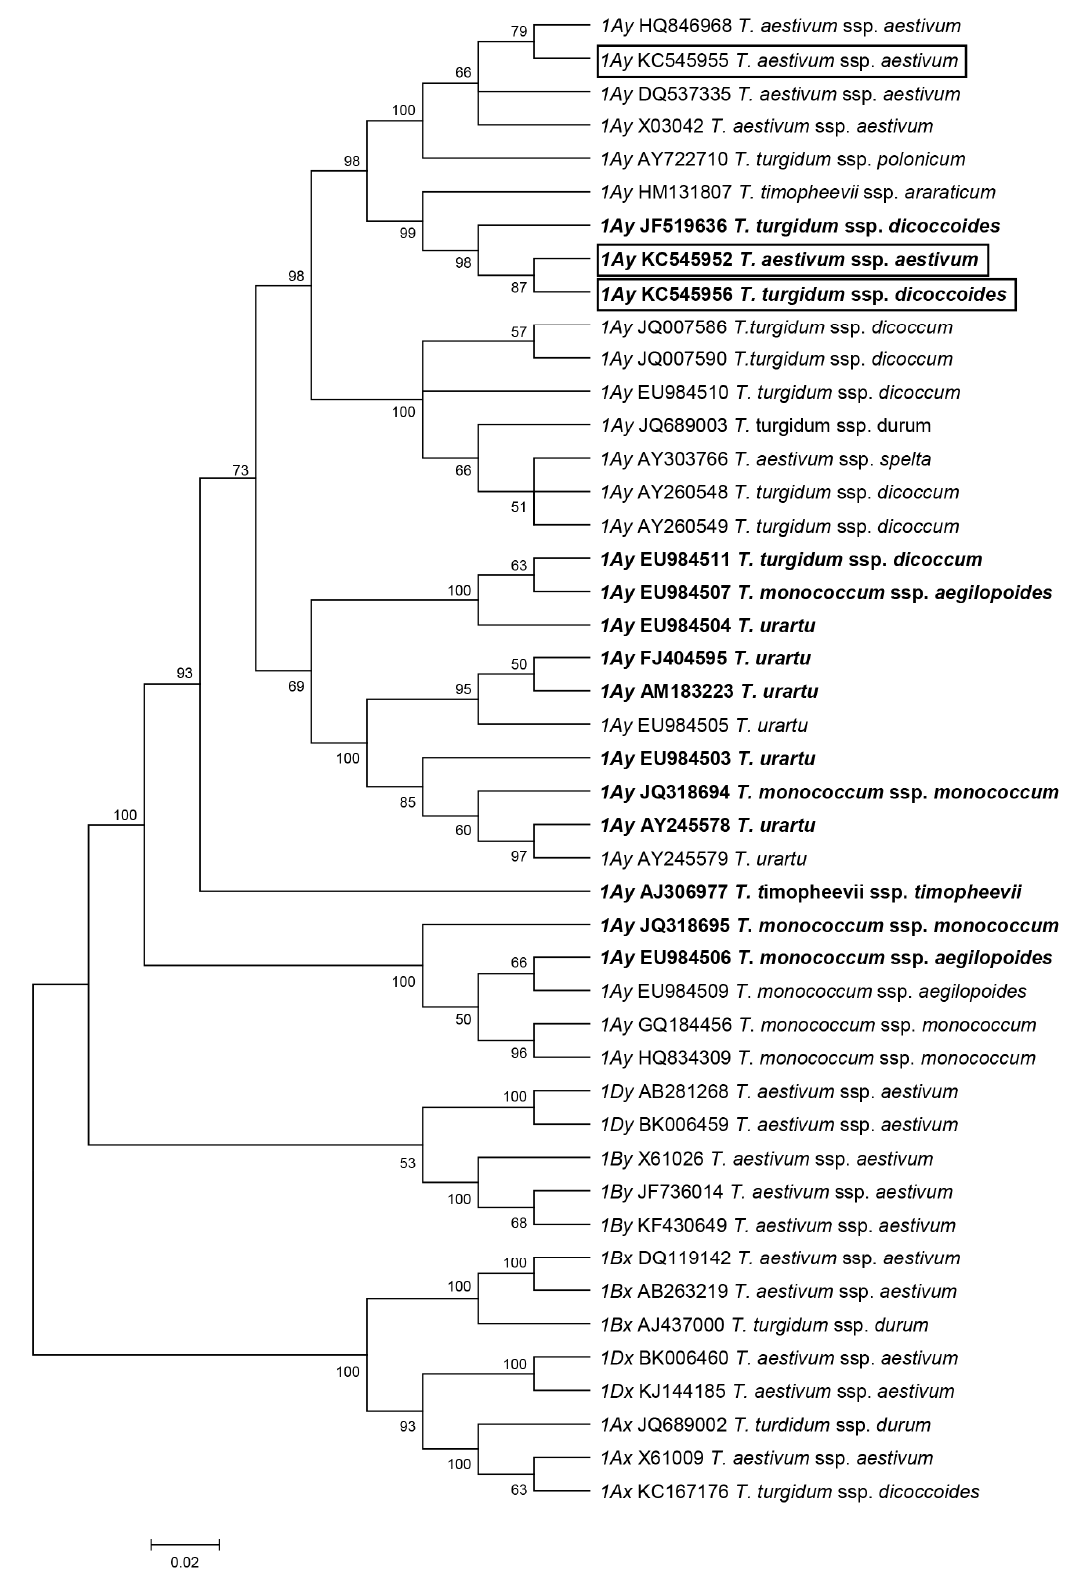
Figure 6. Phylogenetic relationships between the three new Glu-1Ay alleles with previously published HMW-GS genes in wheat ( 1Ay , 1By , 1Bx , 1Dx , 1Dy , 1Ax ). The phylogenetic tree was created based on a multiple alignment of DNA sequences. The three new 1Ay genes are marked by boxes and the 14 1Ay active genes are marked in bold.